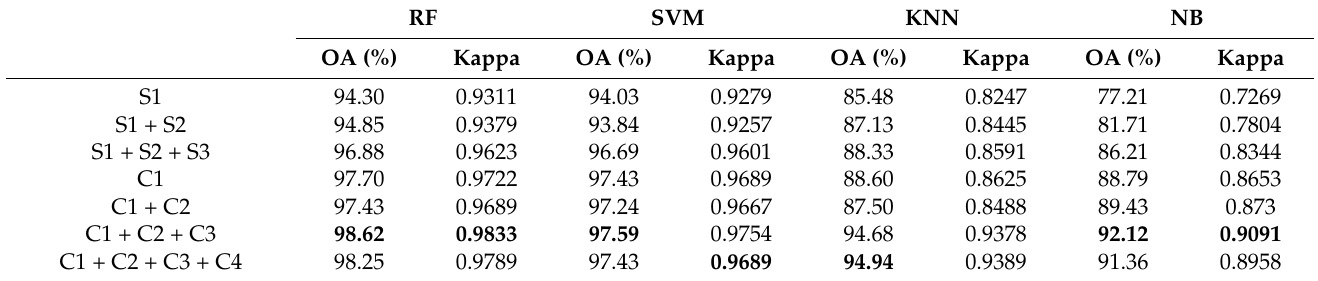
Table 5. Accuracy assessment for object-based classifiers under different feature